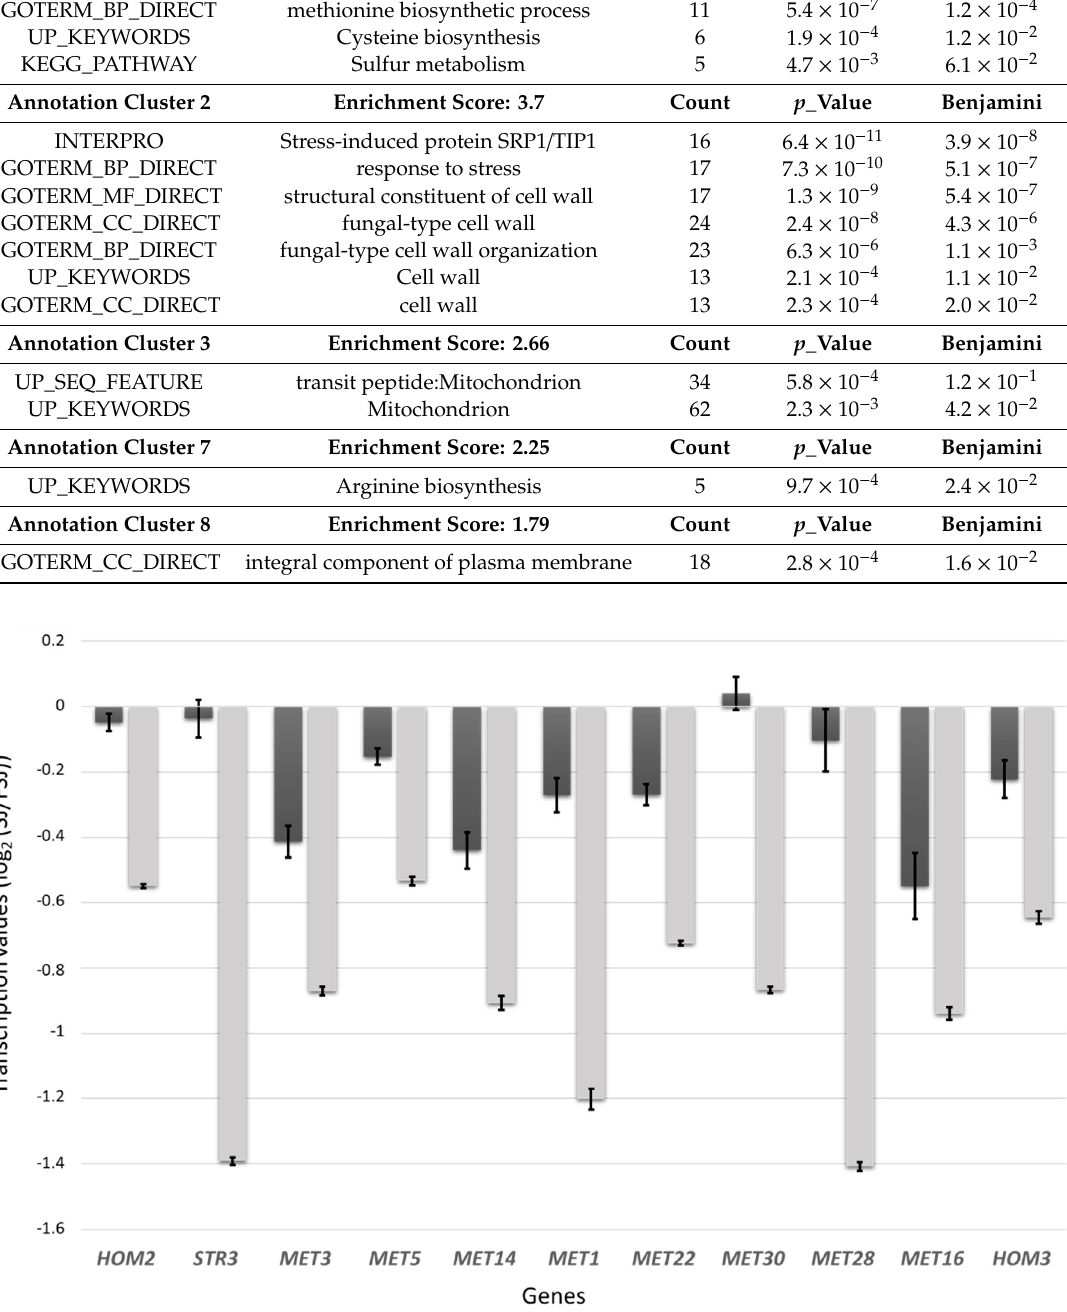
Figure 4. Transcription values of genes differentially expressed in EC1118 (black bars) and M25 (gray bars) in the functional category GO:0009086 “methionine biosynthetic process”. Data are mean log2 ratio (SJ/FSJ) ± standard deviation of three independent biological replicates.